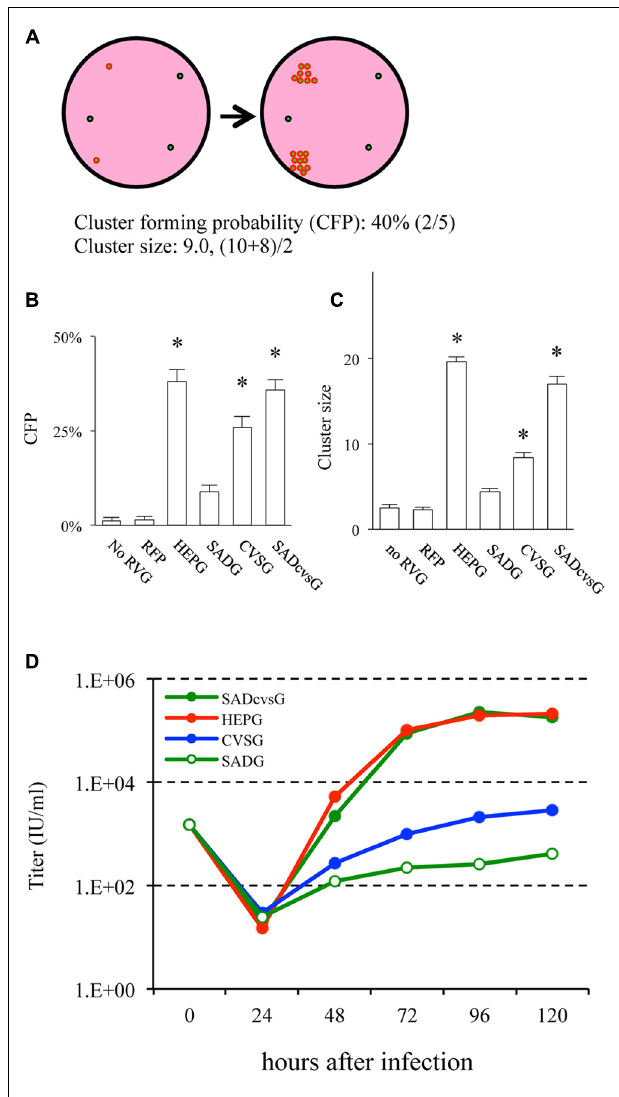
FIGURE 3 | RVG variants differentially amplify HEP- Δ G-GFP. (A) Definitions of cluster-forming probability (CFP) and cluster size. (B) CFP and (C) cluster sizes obtained under various transfection conditions. Asterisks indicate significant differences from SADG (see Materials and Methods). (D) Viral titer growth curves of HEP- Δ G-GFP on BHK cells transfected with one of the RVG